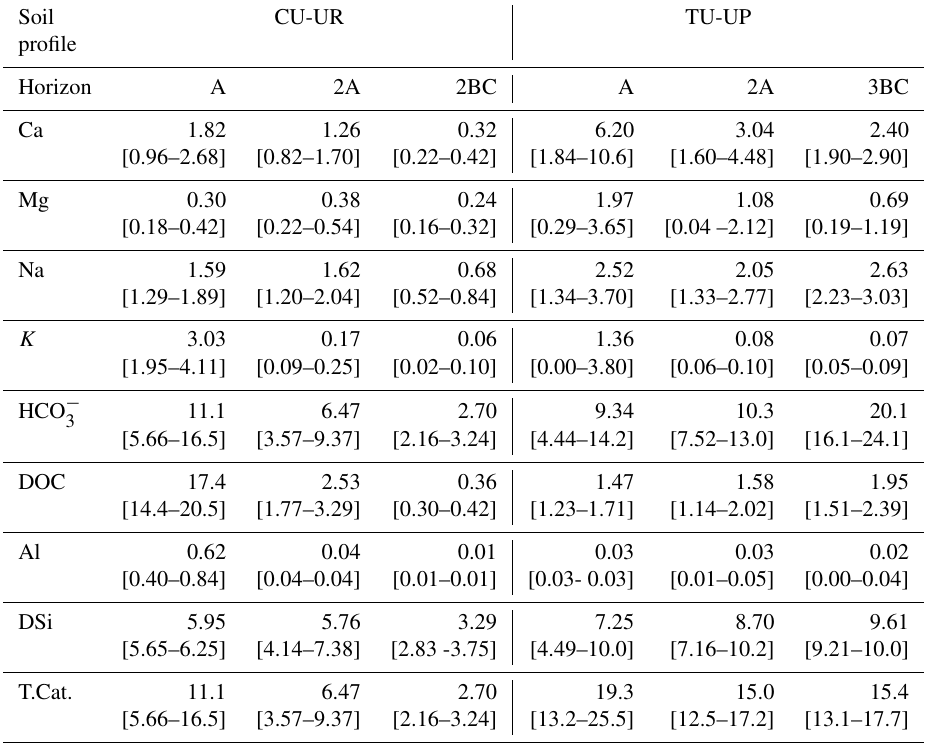
Table 5. Mean (and 95% confidence interval) of the annual solute fluxes (gm − 2 yr − 1 ) for both study sites. Soil CU-UR TU-UP